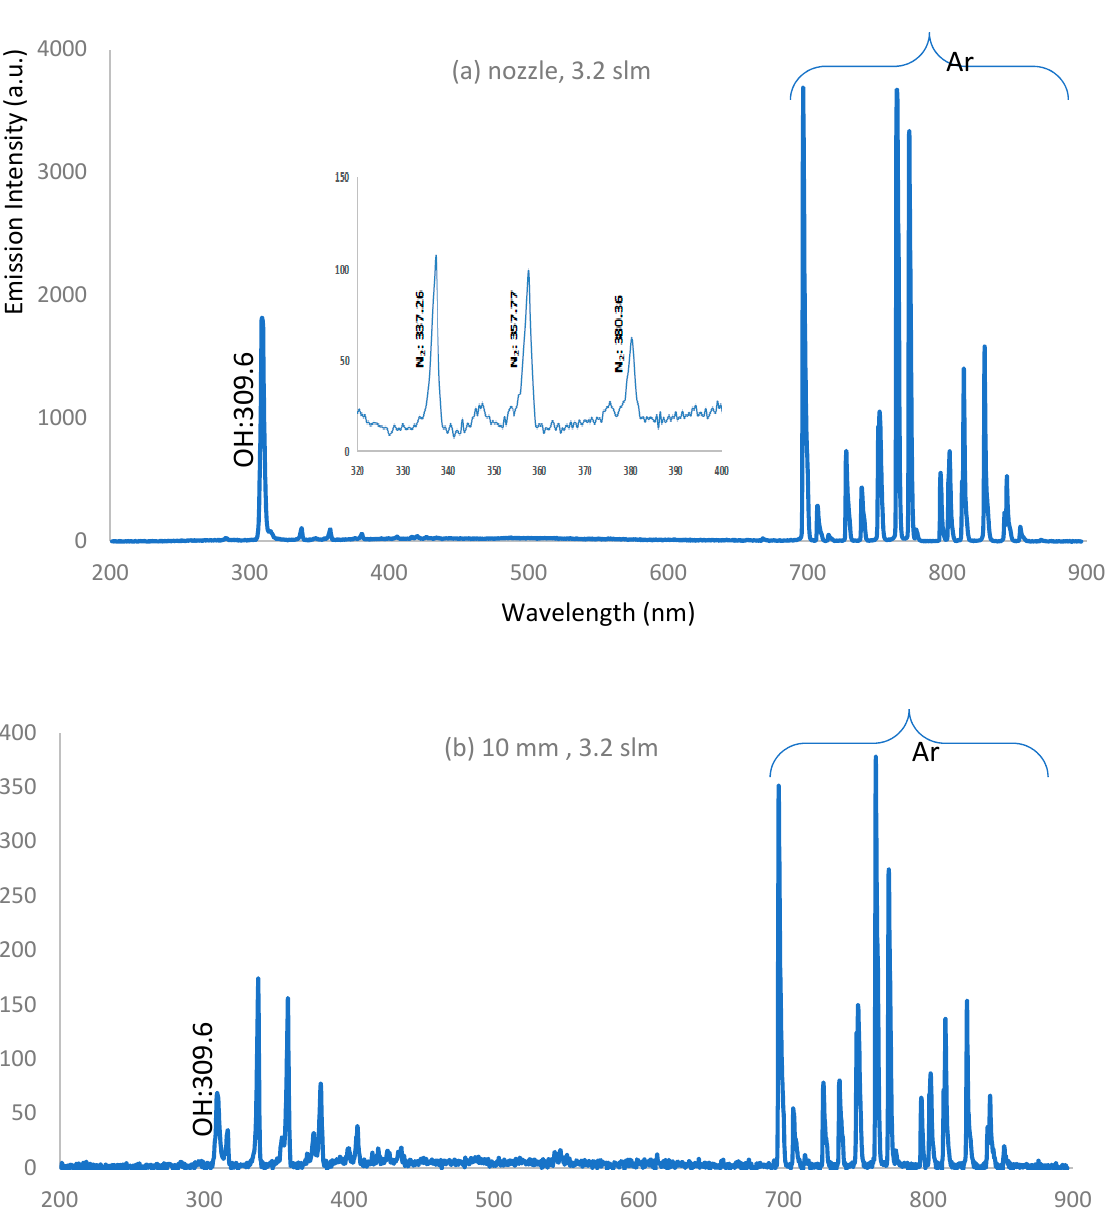
Figure 12. Optical emission spectra of APPJ using argon discharge at an applied flow rate of 3.2 slm for ( a ) nozzle and ( b ) 10 mm.